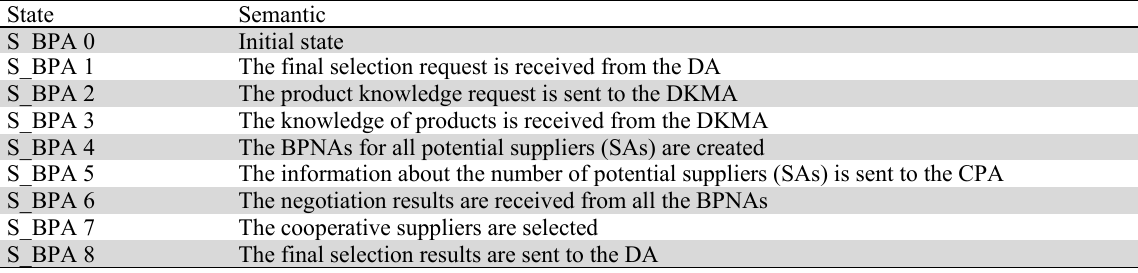
Fig. 4. State transition diagram of the BPA The BPA’s states and their semantics